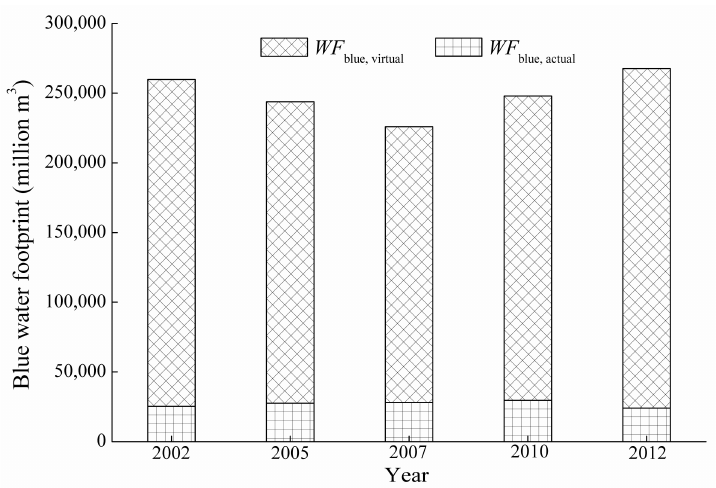
Figure 3. Blue water footprint of China from 2002 to